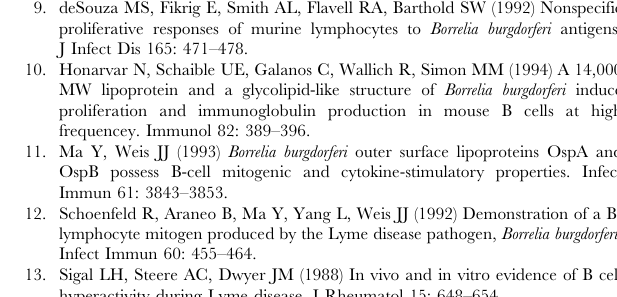
Table S1 Primers for the generation of recombinant